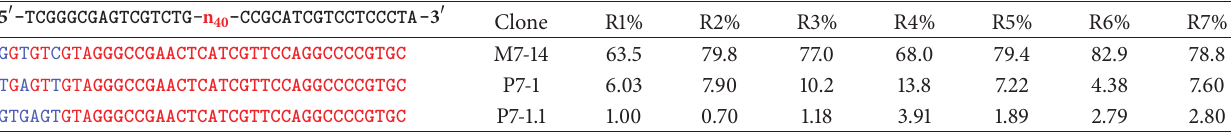
Table 1: Analysis of the cell-SELEX